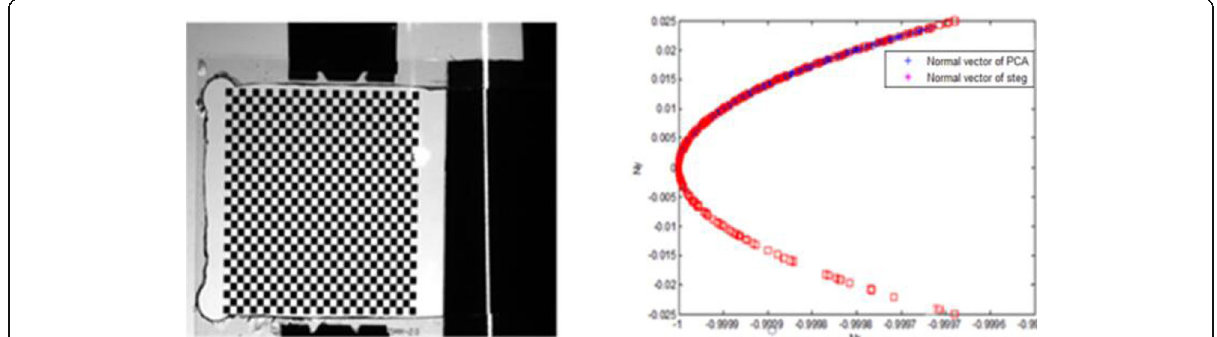
Fig. 10 Image of the plane target and the normal vector of center points (approximate vertical state). a The approximate vertical bars. b The normal vector